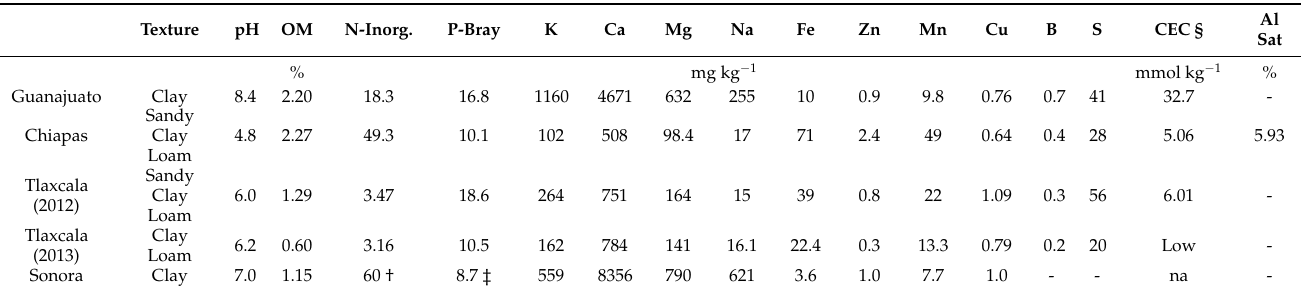
Table 2. Physical and chemical soil characteristics of the experimental sites in Mexico, from 2012–2013, and from